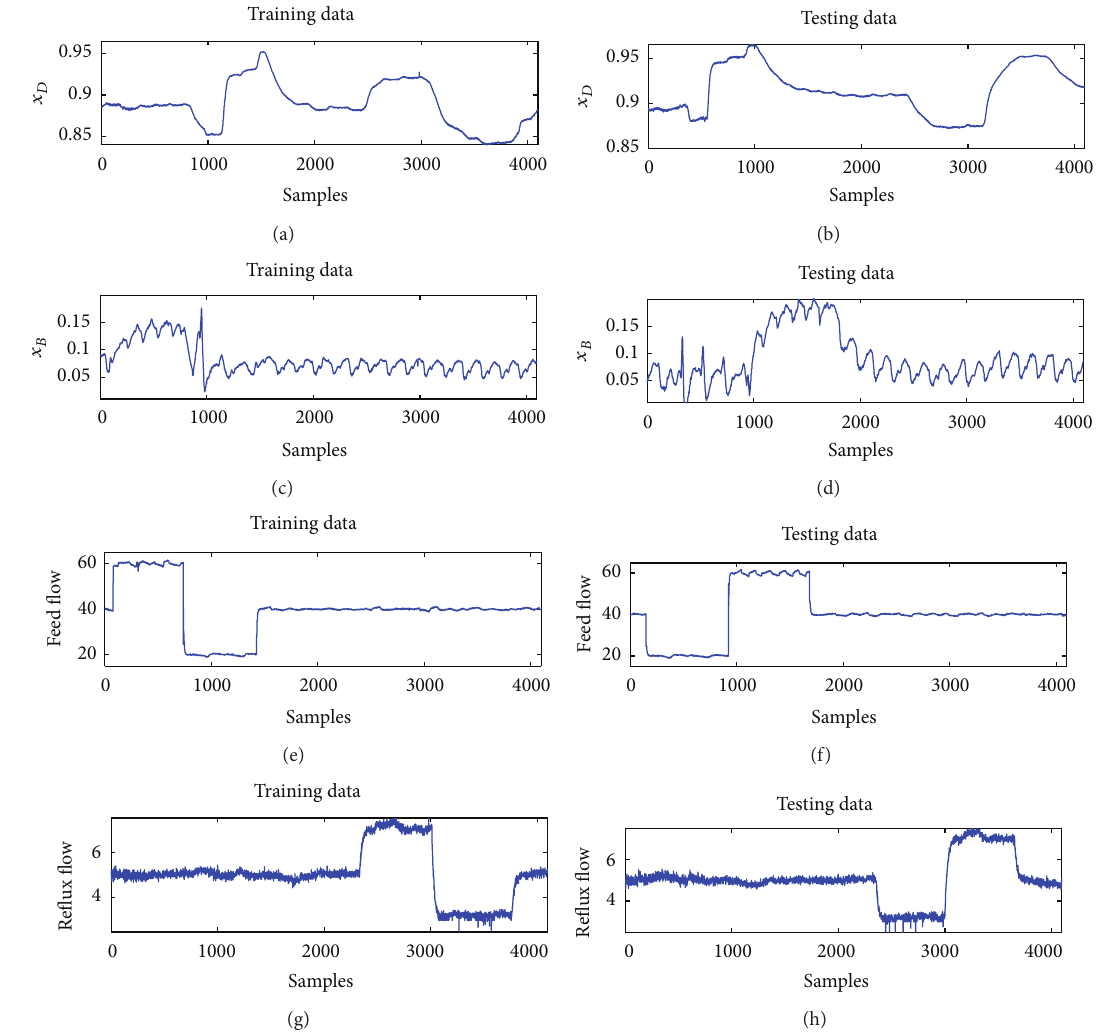
Figure 9: Training and testing data used in the packed bed distillation column modeling